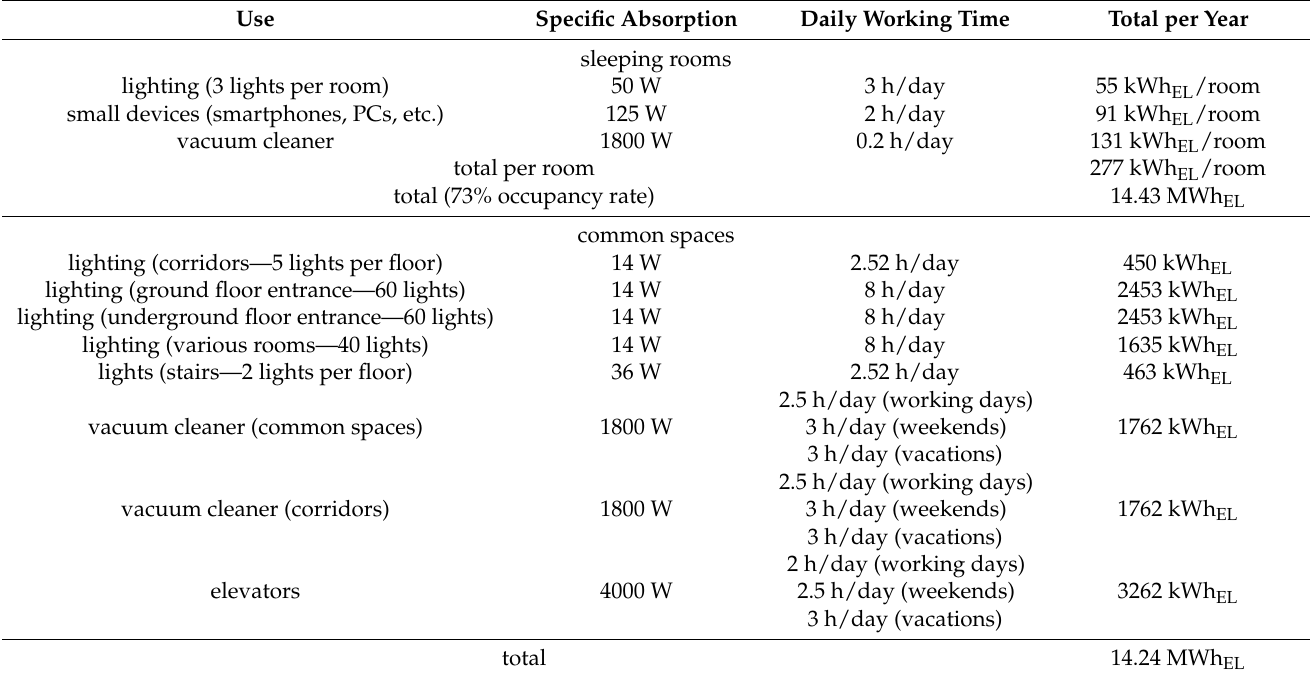
Table A3. Data and parameters for electrical appliances energy needs.